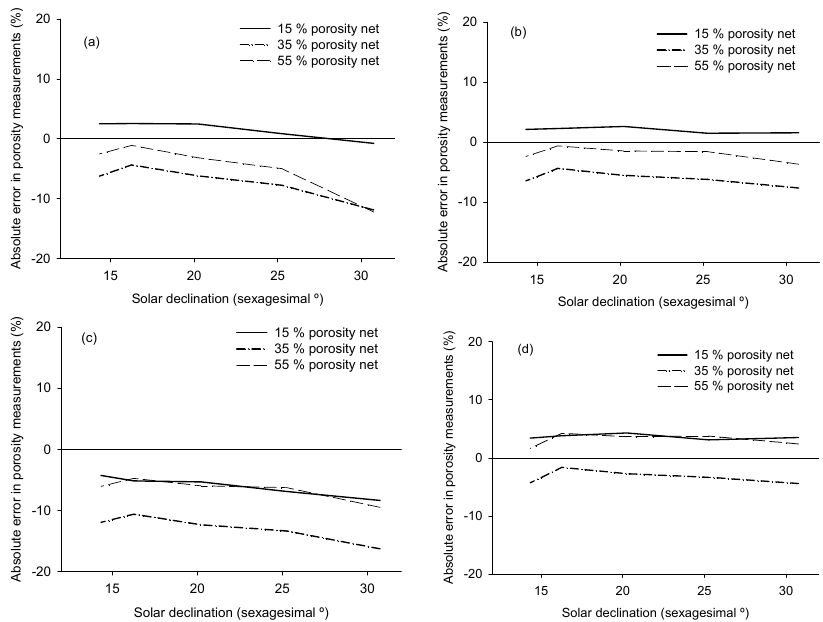
Figure 5. The accuracy of porosity measurement and absolute error of different porous nets depending on solar zenith angle. ( a ) Absolute error for Algorithm 1; ( b ) absolute error for algorithm 2; ( c ) absolute error for algorithm 3; ( d ) absolute error for algorithm 4.